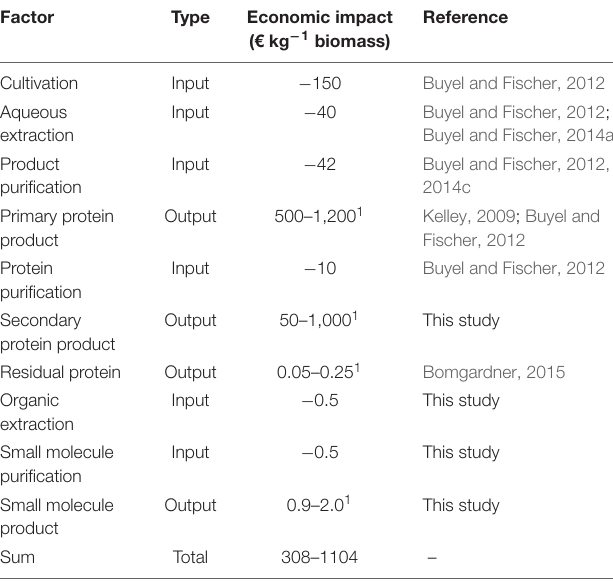
TABLE 1 | Economic potential of process integration for plant-derived